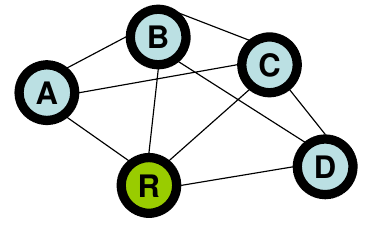
Figure 8. Simple network